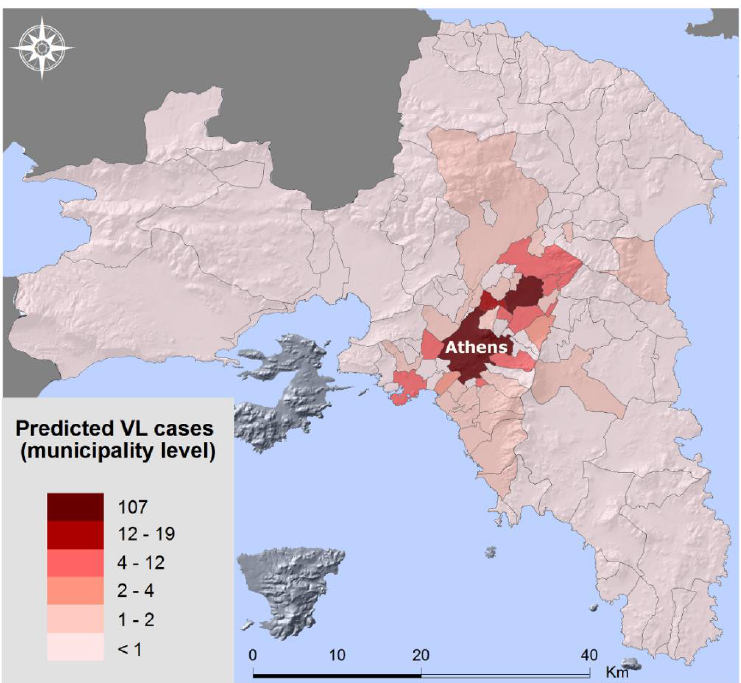
Figure 5. Risk map for leishmaniasis (spatial regression model).